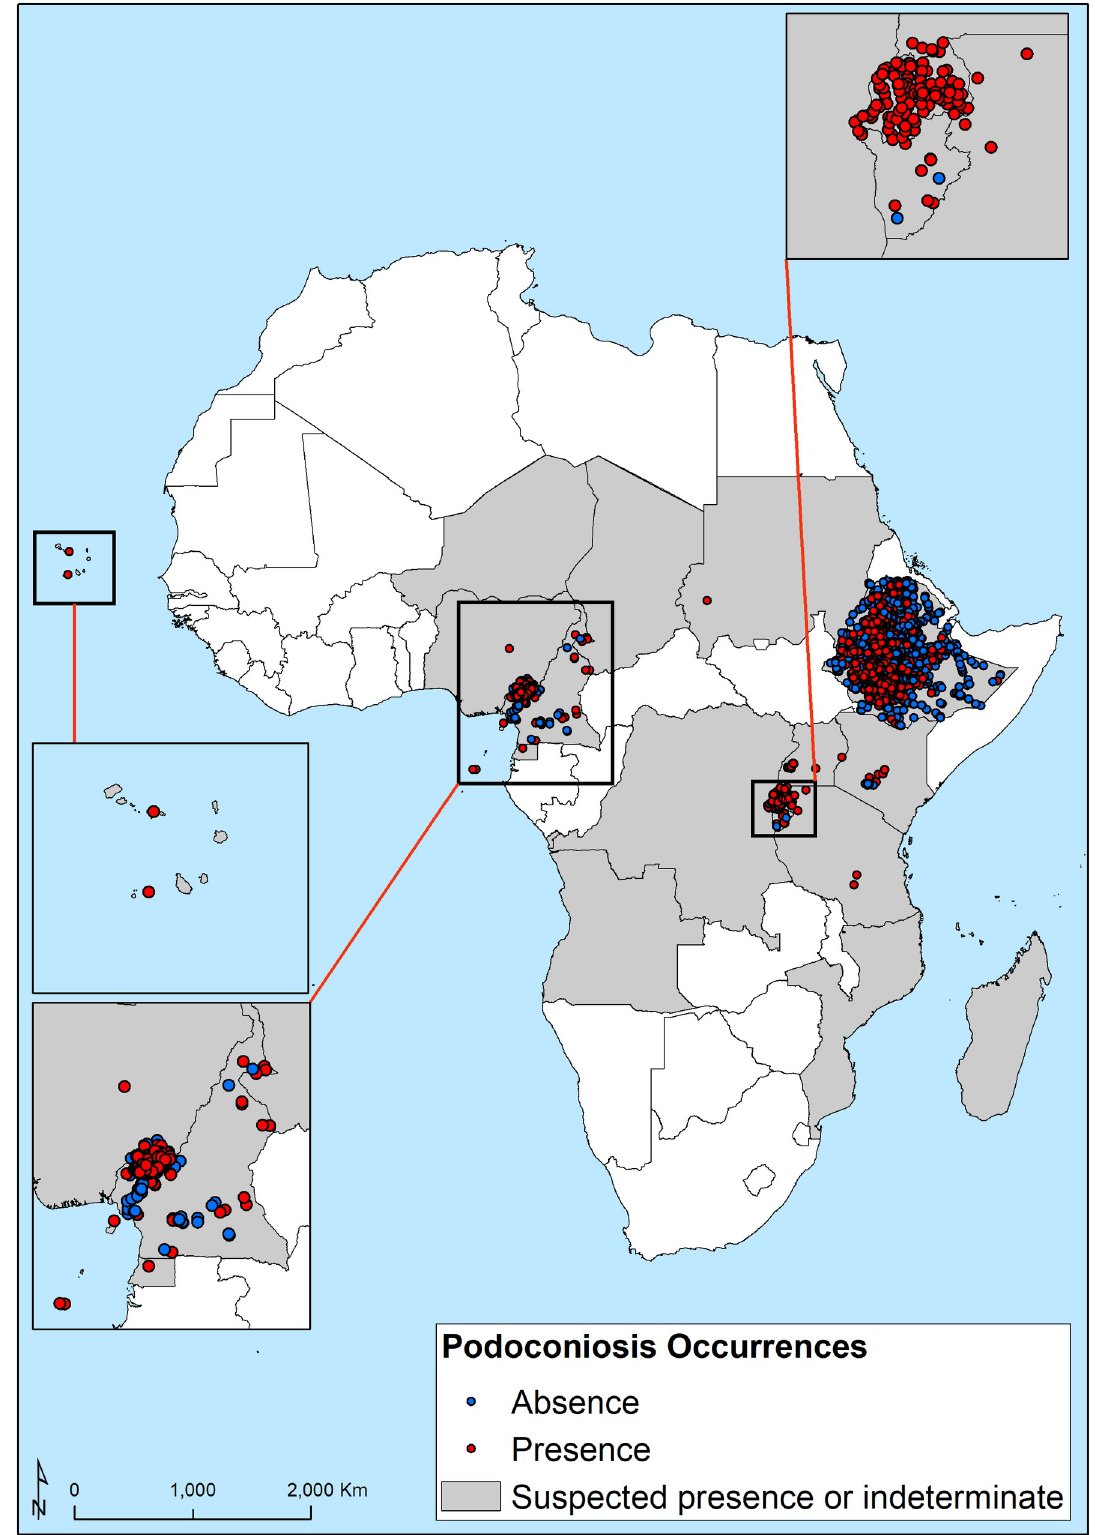
Fig 1. Geographical distribution of presence and absence surveys used in the predictive map of occurrence. Red dots correspond to survey locations where podoconiosis has been reported (n = 1,311). https://doi.org/10.1371/journal.pntd.0008616.g001 PLOS NeglectedTropical Diseases | https://doi.org/10.1371/journal.pntd.0008616 August 27,